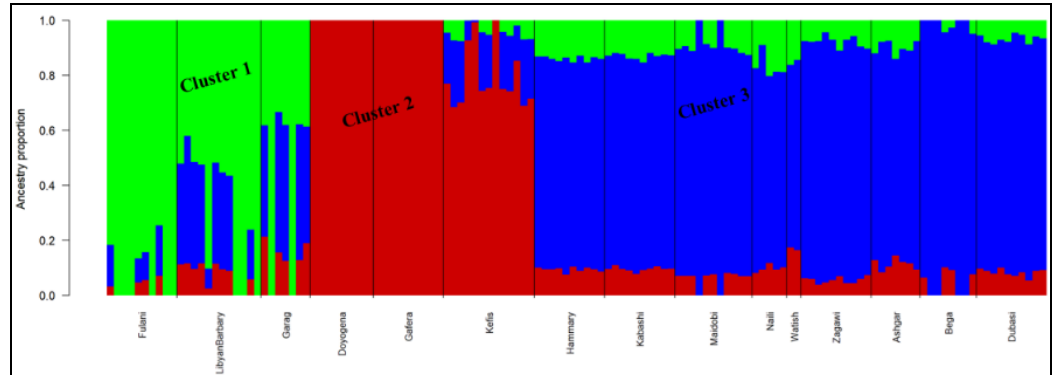
Figure 6. Analysis of admixture in the continental dataset. The three genetic clusters are designated. (Cluster 1: Fulani, Libyan Barbary, Garag; Cluster 2: Doyogena, Gafera, Kefis; Cluster 3: Hammari, Kabbashi, Maidobe, Naili, Watish, Zagawi, Ashgar, Bega, Dubasi).